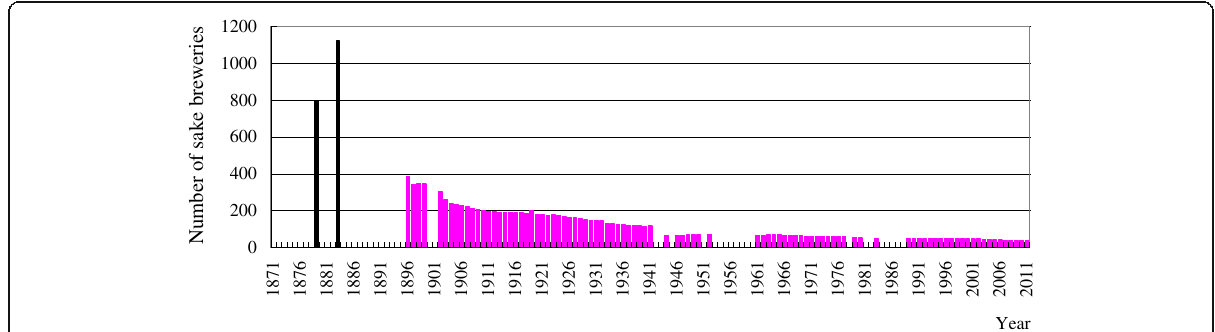
Fig. 5 Numbers of sake-brewery licensed in Chiba Prefecture (Chiba Prefecture 2012). Black bars indicate pre-home-brewing prohibition values